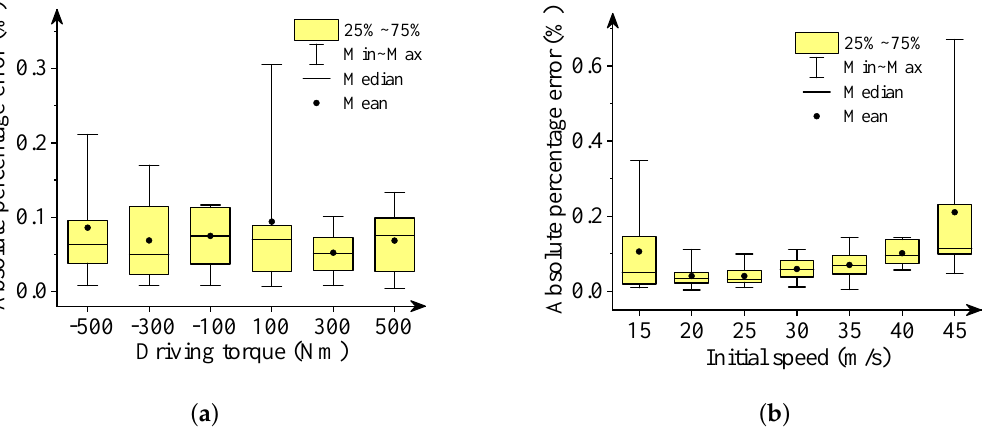
Figure 8. Box plots of absolute percentage error: final longitudinal velocities. ( a ) Driving torque; ( b ) Initial